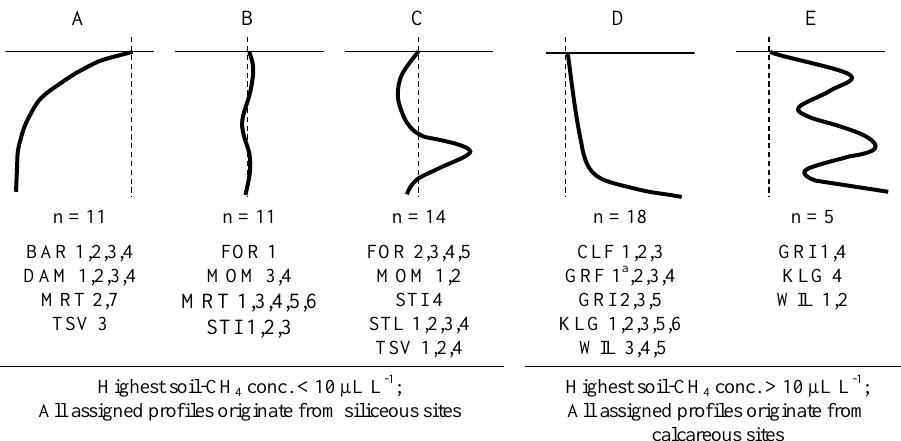
Fig. 5. Qualitative categories A–E assigned to measured soil-gas CH 4 profiles according to profile appearance. Illustrated profile shapes are typical for each category. The vertical line indicates atmospheric CH 4 concentration. Sampled locations assigned to the respective categories are listed